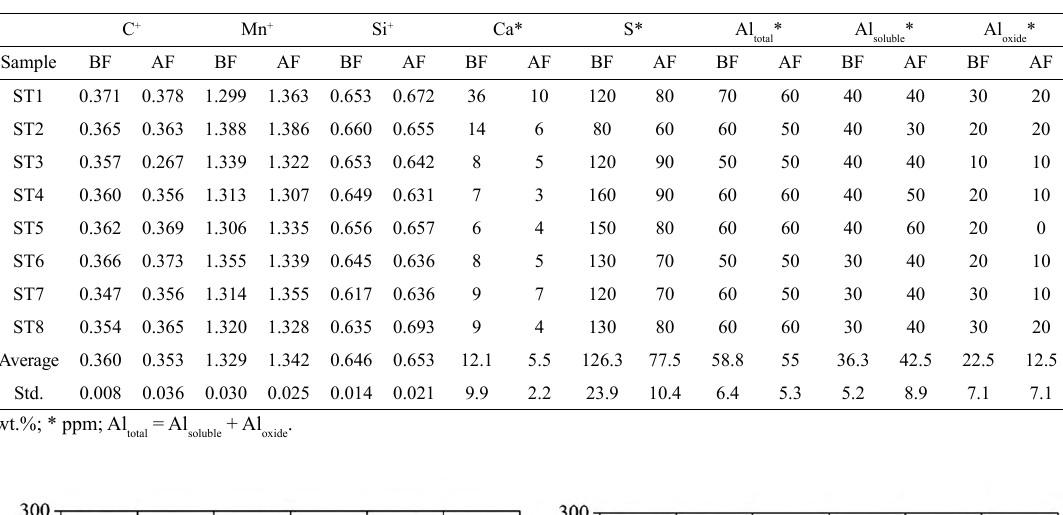
* Al * Al * total soluble oxide